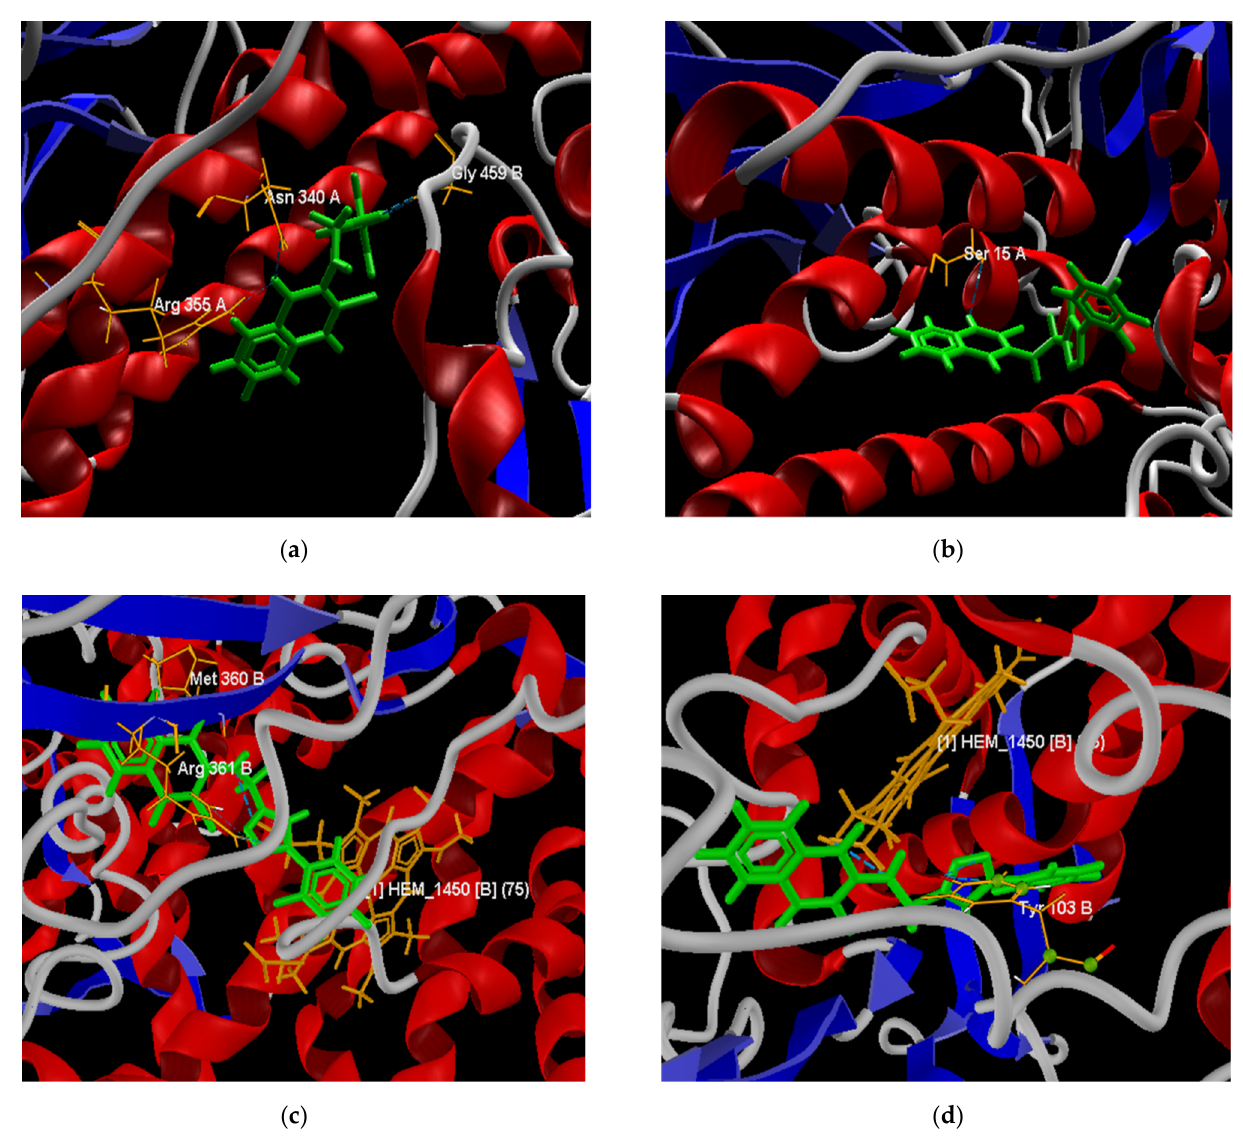
Figure 7. Best poses of derivatives 64 ( a ) and 66 ( b ) in the active site of the Tc TR protein. Best poses of derivatives 66 ( c ) and 68 ( d ) in the active site of the Tc L α D protein.